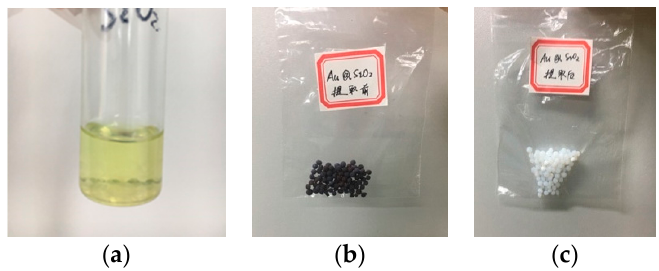
Figure 10. ( a ) Au@SiO 2 leaching process; ( b ) Au@SiO 2 before leaching; ( c ) Au@SiO 2 after leaching.